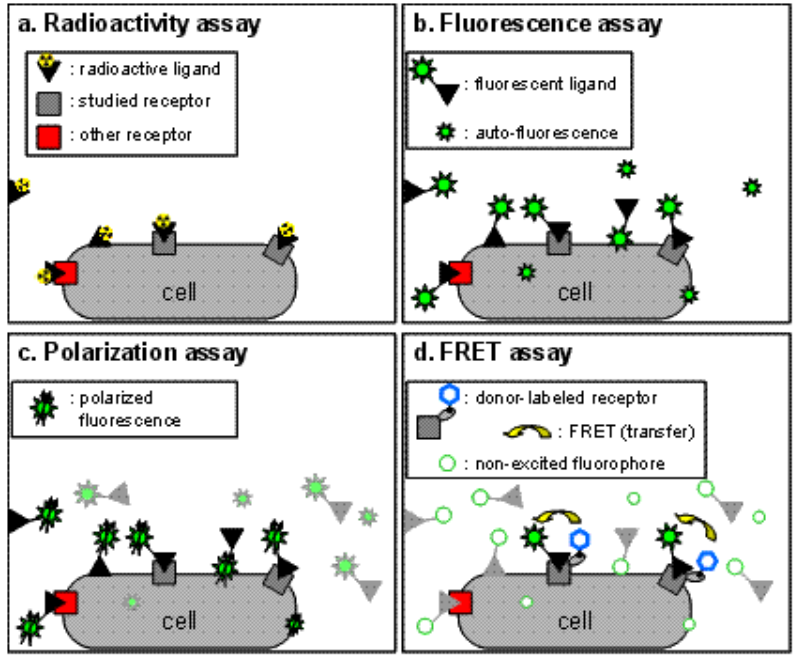
Figure 1. Different binding assay methods. (a) Radioactive binding assay performed in a heterogeneous format, with washing steps to eliminate the excess of unbound radioactive ligand. Noise can come from non-specifically bound ligand;(b) Fluorescence binding assay performed similarly to radioactive assays. Noise can result from auto-fluorescence of the sample and non-specifically bound ligands; (c) Polarization binding assay performed in a homogeneous format: the excess of labeled ligand is not removed as only the immobilized fraction (e.g. bound ligands) will retain the fluorescence polarization; (d) Homogeneous FRET-based binding assay, with only the specifically bound fluorescent ligand participating in the FRET, therefore increasing the signal-to-noise